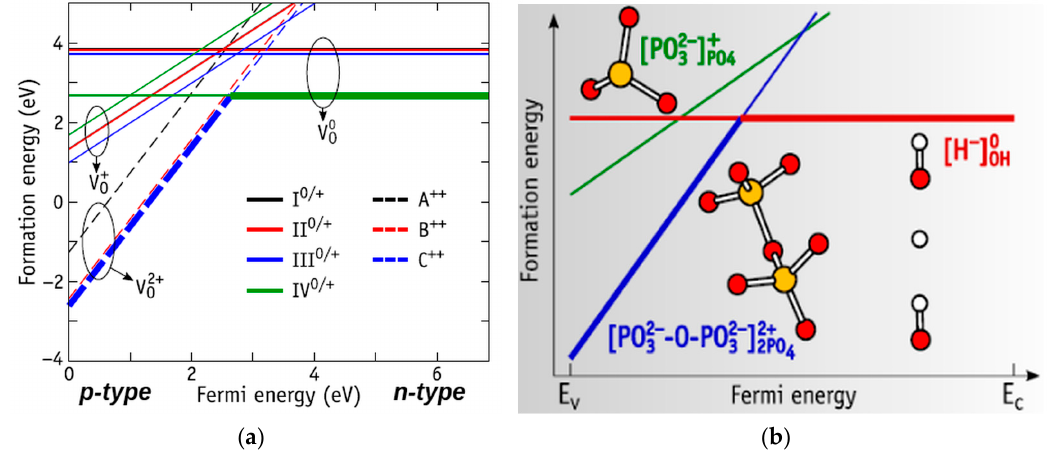
Figure 15. ( a ) Energy diagram of formation of the V O defect in HAp as a function of the Fermi energy. The solid lines represent formation energies of neutral and single positive defects with structures I − IV, while the dashed lines represent double-positive defects with structures A − C. ( b ) Scheme of A + /C ++ defects. Reprinted and modified with permission from [35]. Copyright (2019) American Chemical Society.